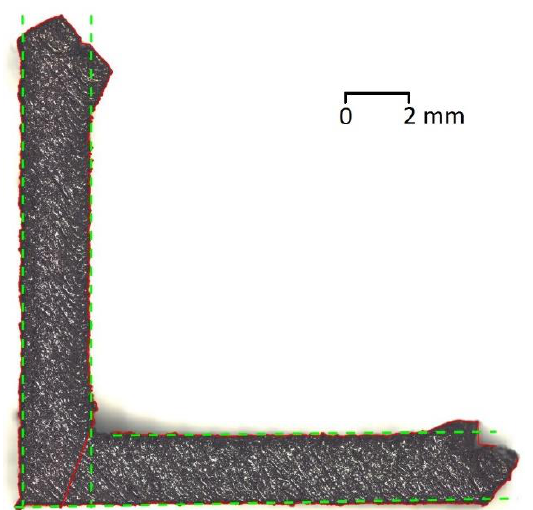
Figure 3. Printed part that underwent image processing, where green lines indicate the detected edges that were used for measurement.